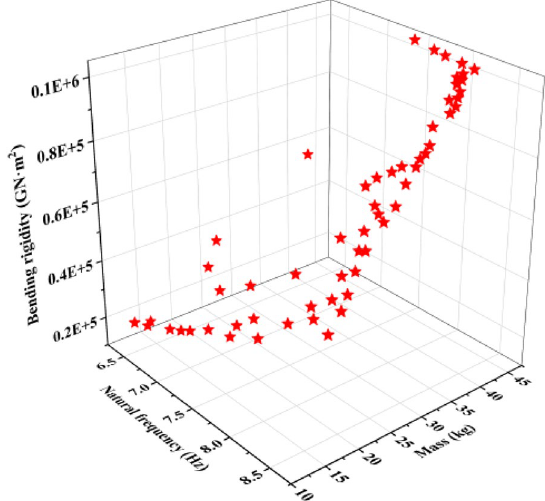
Figure 18 Prototype of